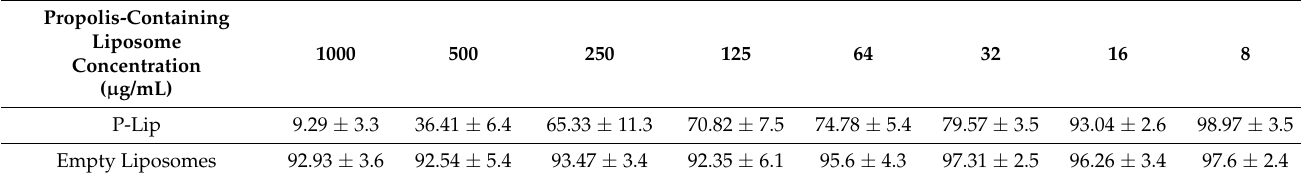
Table 5. The mean viability percentage of Hep-2 cells treated with decreasing concentrations of propolis-loaded liposomes and corresponding empty liposomes for 24